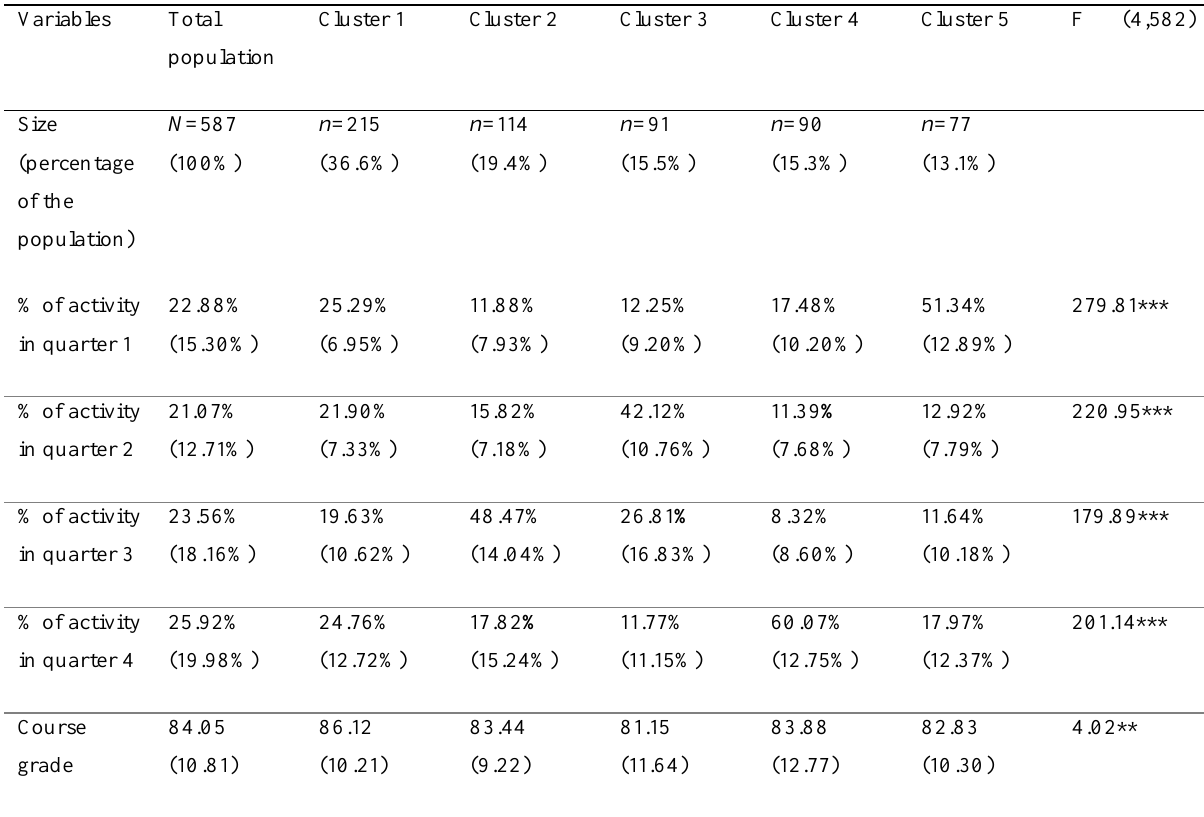
Clusters by Learning Time During the